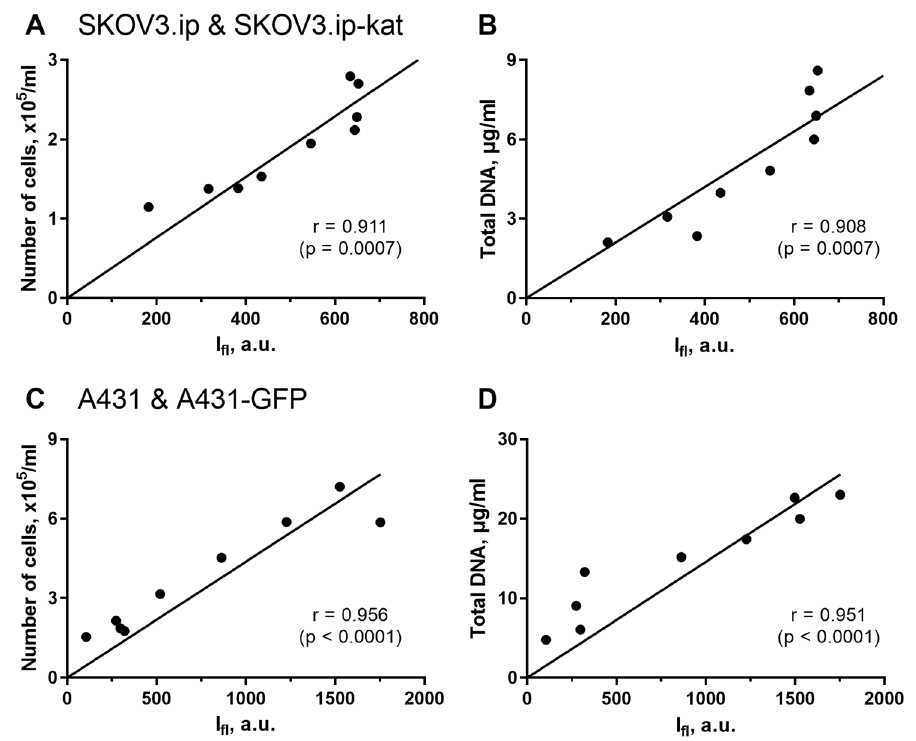
Figure 2. Analysis of correlation between fluorescence-based and invasive methods for assessing tumor cell growth in 3D collagen models. Regression analysis was performed for integral fluorescence intensity vs. number of cells ( A , C ); and for integral fluorescence intensity vs. total DNA content ( B , D ). The data for SKOV3.ip(kat) ( A , B ) and A431(GFP) ( C , D ) cells are presented. The Pearson correlation coefficients (r) with significance level ( p ) are indicated for all the comparisons.